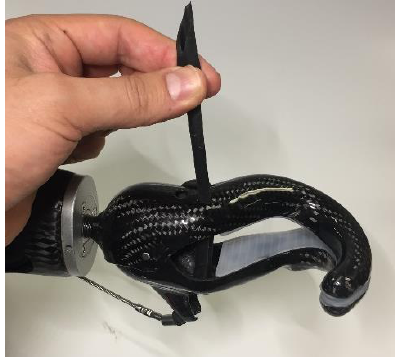
Figure 10. Continuous force regulation